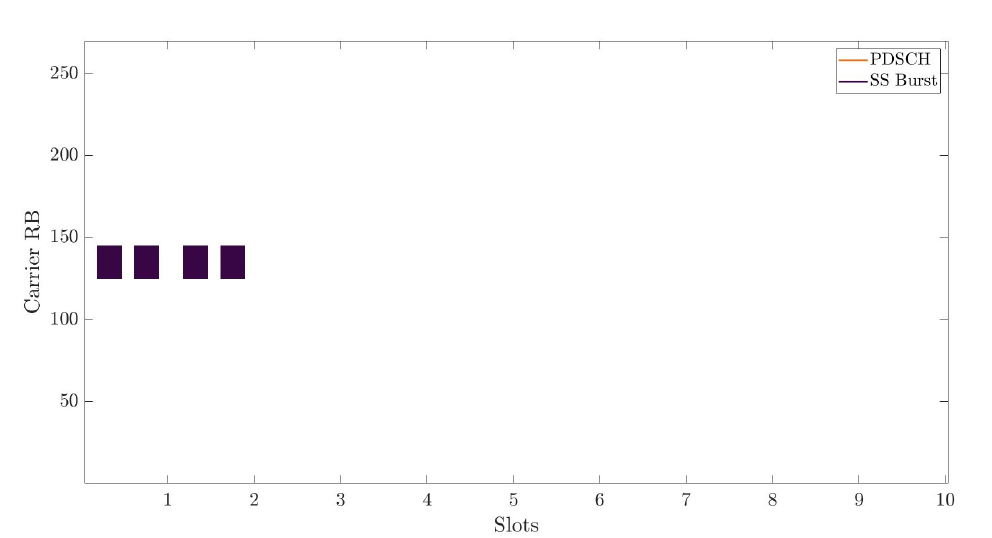
Figure 7. Resource grid with no data payload, only the SSB signal is